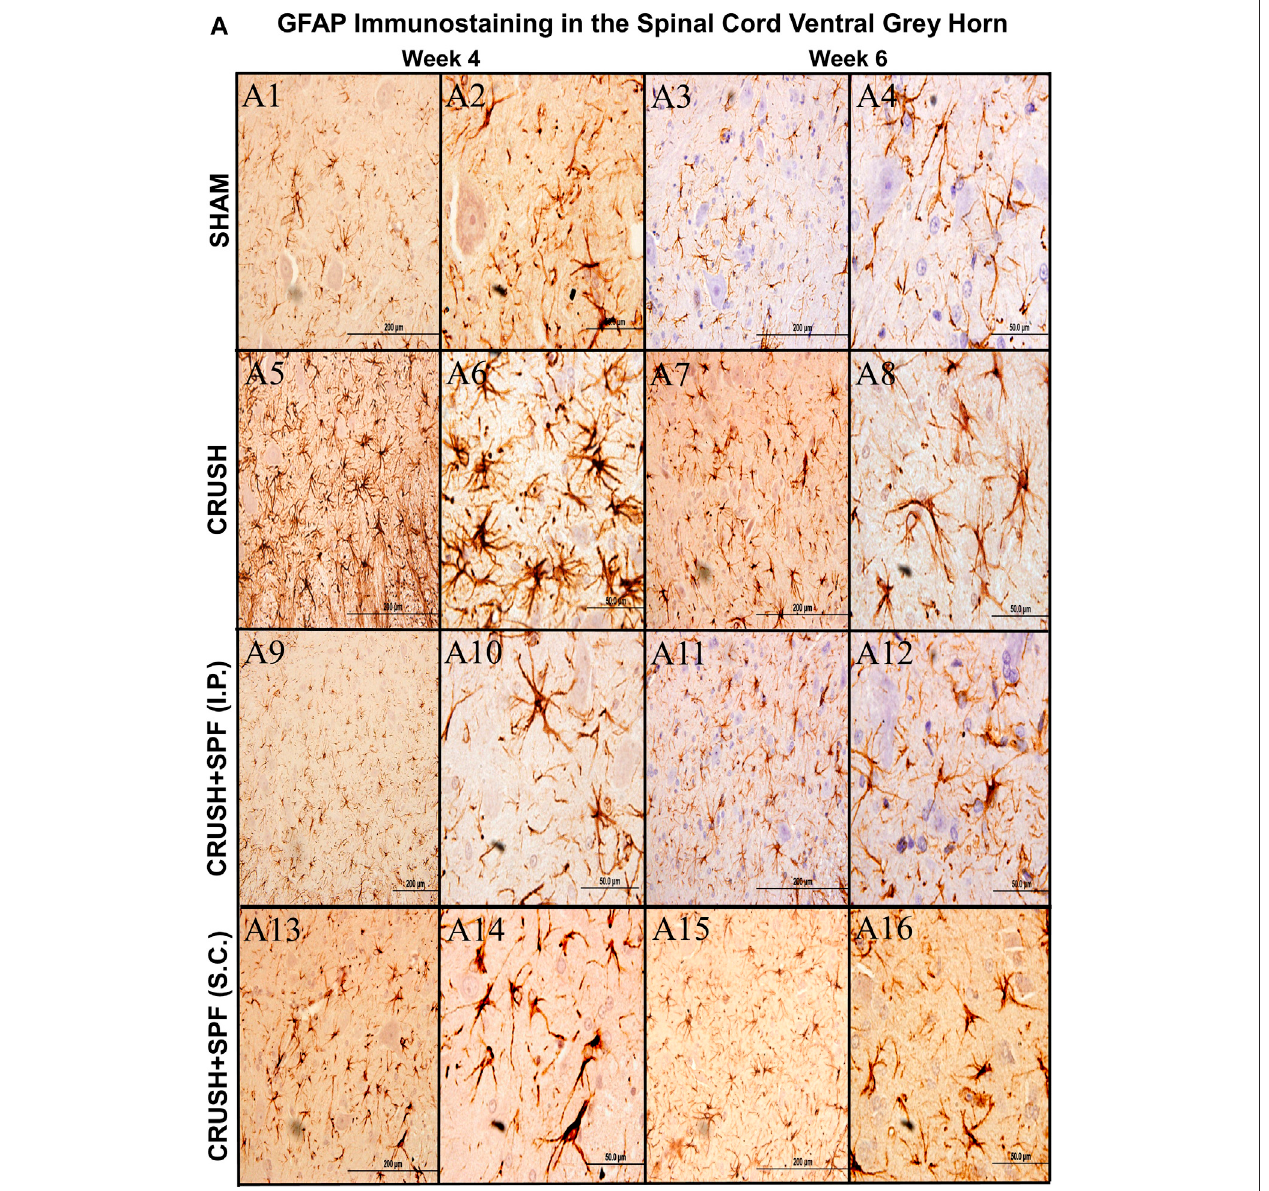
FIGURE 9 | (A) : Representative 40 × and 100 × photomicrographs of lumbar spinal cord ventral grey horn immunostained for GFAP at Week 4 and Week 6 post- injury. Note an increasing number of GFAP-immunoreactive astrocytes in the CRUSH group compared to the SHAM and IP and S.C. SPF-FB-treated groups. (B) : Bar graph shows the number of GFAP-immunoreactive astrocytes in the ipsilateral ventral grey horn at week 4 and week 6 post-injury. Note the signi fi cant increase in the number of GFAP-immunoreactive astrocytes in the CRUSH group. In contrast, the number of GFAP-immunoreactive astrocytes signi fi cantly decreased in the CRUSH + 1X SPF-FB(S.C.) and CRUSH + 0.5X SPF-FB(S.C.)-treated groups. * indicates p < 0.0001 CRUSH vs. All groups; ¥ indicates p < 0.0001 CRUSH + 1X SPF- FB(S.C.) vs. all groups; Φ indicates p < 0.002 CRUSH + 0.5X SPF-FB(S.C.) vs. CRUSH and CRUSH + SPF-FB (IP). (C) : Bar graph shows the number of GFAP- immunoreactive astrocytes in the ipsilateral dorsal grey horn at week 4 and week 6 post-injury. Note the signi fi cant increase in GFAP-immunoreactive astrocytes in the CRUSH group compared to all experimental groups. Moreover, IP and S.C. SPF-FB treatments signi fi cantly decrease the number of GFAP-immunoreactive astrocytes atWeek4andWeek6followingsciaticnerveinjury.*indicates p < 0.0001CRUSHvs.Allgroups;¥indicates p < 0.02CRUSH+1XSPF-FB(S.C.)vs.SHAM; Φ indicates p < 0.01 CRUSH + 0.5X SPF-FB(IP) vs. SHAM; ** indicates p < 0.001 CRUSH + 1X SPF-FB(S.C.) vs. SHAM. (D) : Western blot analysis of GFAP in the lumbar spinal cords at Week 4 and Week 6 following nerve injury. (E) : Bar graph shows the GFAP density in spinal cord samples. Note signi fi cantly decreased GFAP content in the CRUSH+0.5XSPF-FB-FB(IP)spinalcords-treatedgroups.*indicates p < 0.0001NAÏVEvs.Allgroups;¥indicates p < 0.0001SHAMvs.CRUSH;#indicates p < 0.004 SHAM vs. CRUSH + 01X SPF-FB(S.C.) and CRUSH + 2X SPF-FB(S.C.); Φ indicates p < 0.002 CRUSH vs. CRUSH + SPF-FB(IP); Ψ indicates p < 0.003 SHAM vs. CRUSH + 0.5X SPF-FB(IP); α indicates p < 0.0001 CRUSH vs. NAÏVE and SHAM; ** indicates p < 0.05 CRUSH + 0.05X SPF-FB(IP) vs. CRUSH.